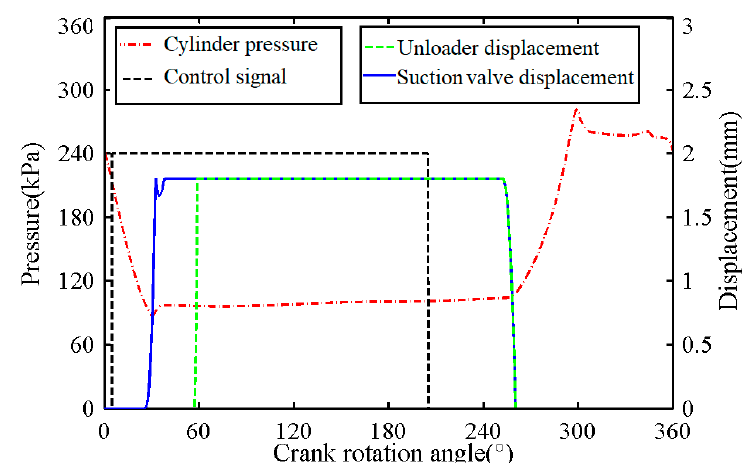
Figure 7. Control signal, suction valve plate, unloader, and cylinder dynamic pressure.